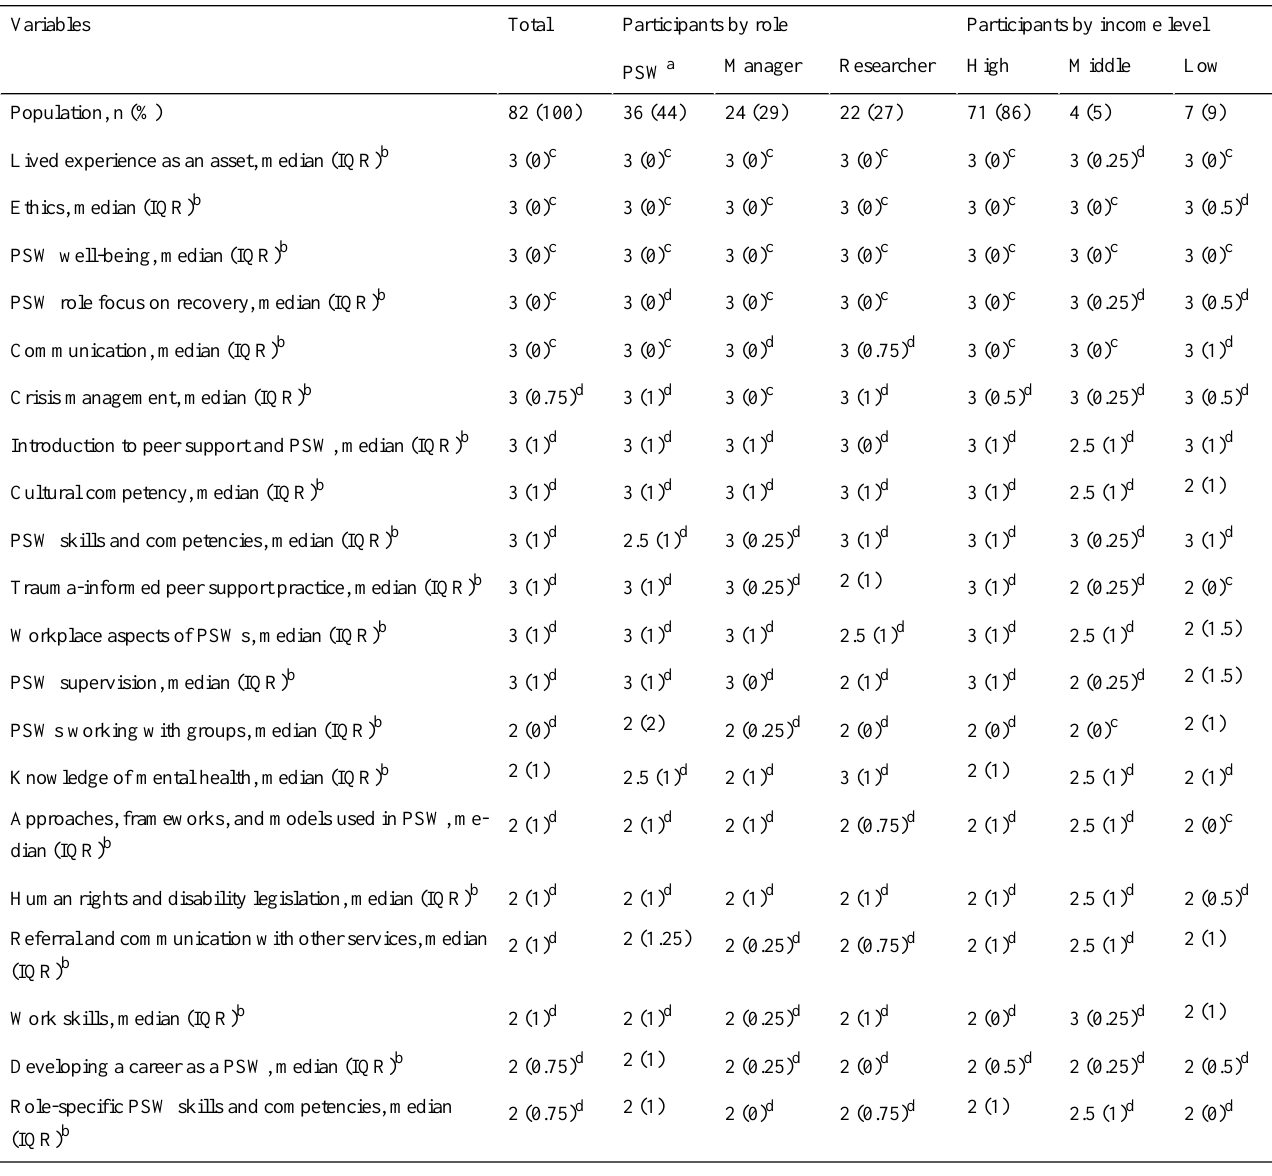
Table 2. Delphi Consultation round 3 rating of importance (n=82).